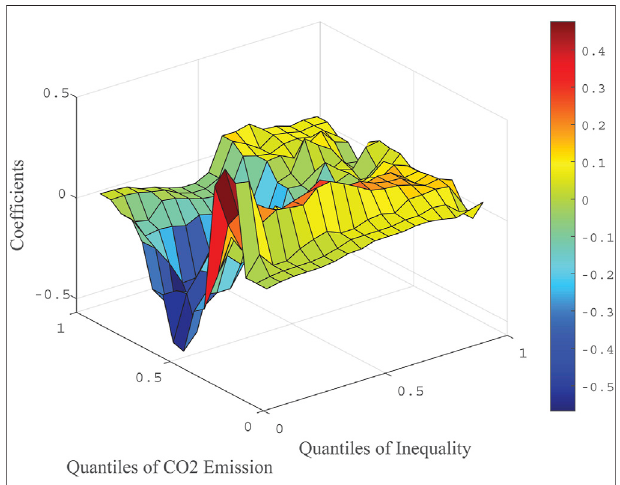
FIGURE 7 | The impact of carbon emission on income inequality (France).